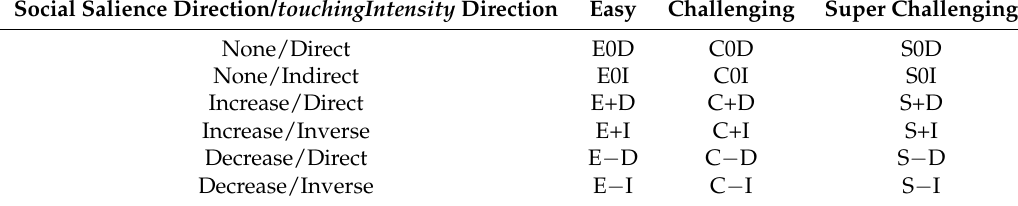
Table 5. Summary of our experimental conditions for experiments where touchingIntensity is modulated by oxytocin, and of the notation used. D refers to conditions where touchingIntensity is directly modulated, I refers to conditions where touchingIntensity is inversely modulated, and 0 refers to no modulation. World conditions (E, C, S) and social salience conditions (0, +, − ) are denoted as